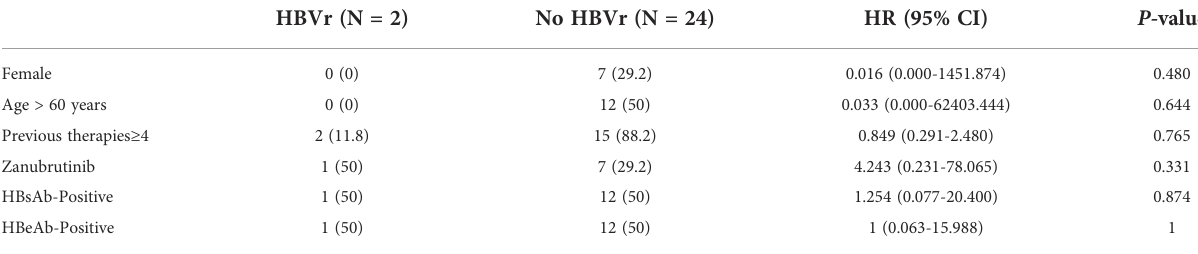
TABLE 3 Univariate Cox regression analysis for HBVr (N = 26). HBVr (N = 2)